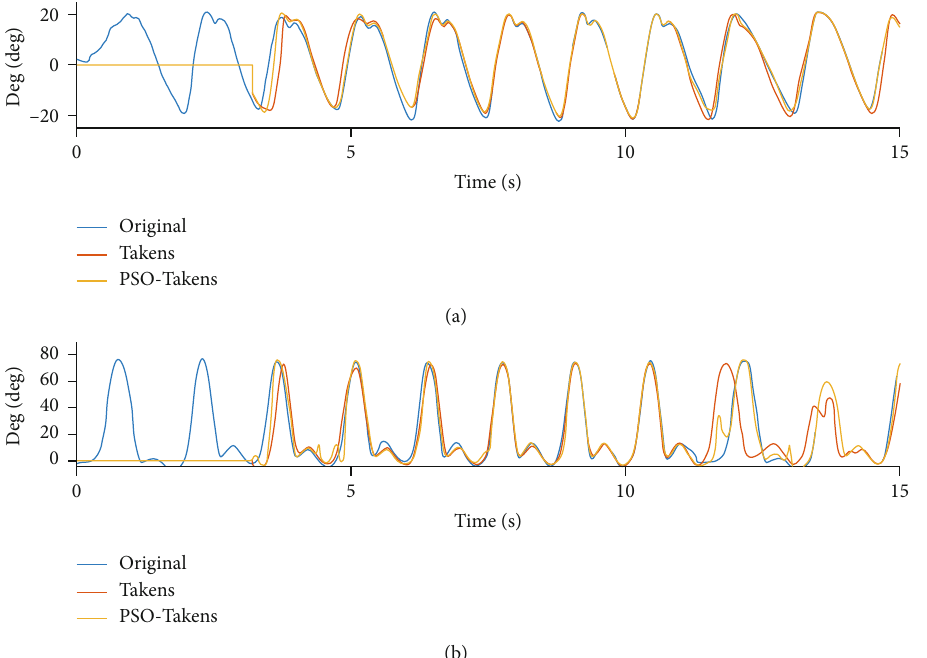
Figure 8: Comparison of Takens and PSO-Takens in prediction of nonstandard gait data. (a) Comparison of hip joint prediction angle. (b) Comparison of knee joint prediction angle.